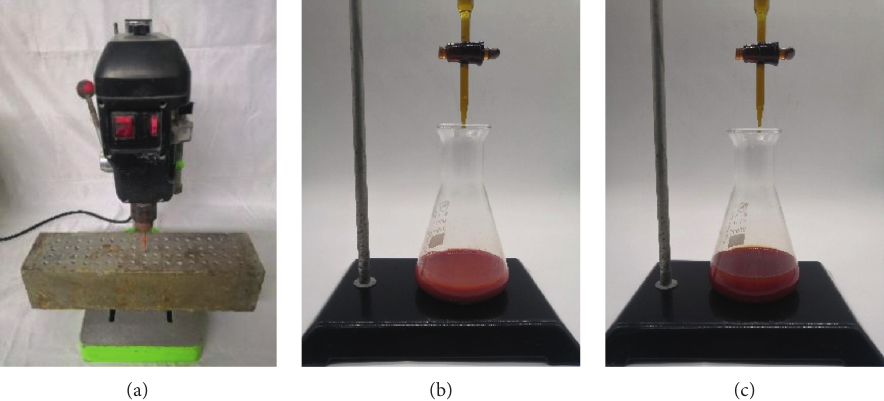
Figure 2: Diamond powder sampling and titration. (a) Sampling. (b) Total chloride ion titrated to red. (c) Free chloride ion titrated to brick red.